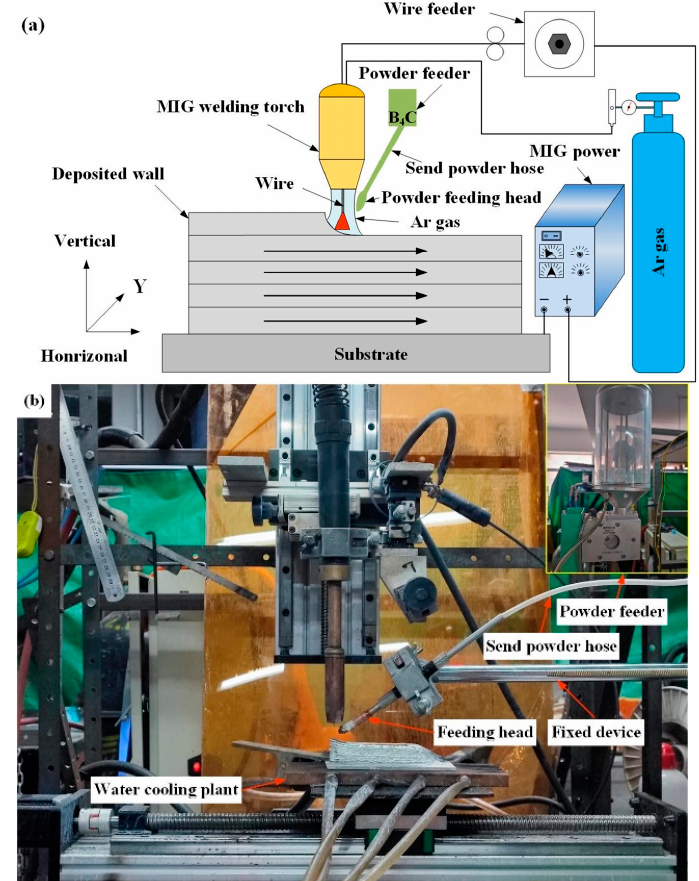
Figure 1. DP-MIG aluminum alloy powder feeding additive manufacturing. ( a ) schematic diagram of the DP-MIG-WAAM process, ( b ) structure of experimental equipment. Table 2. Experiment parameters of DP-MIG wire welding additive manufacturing of 2319 aluminum